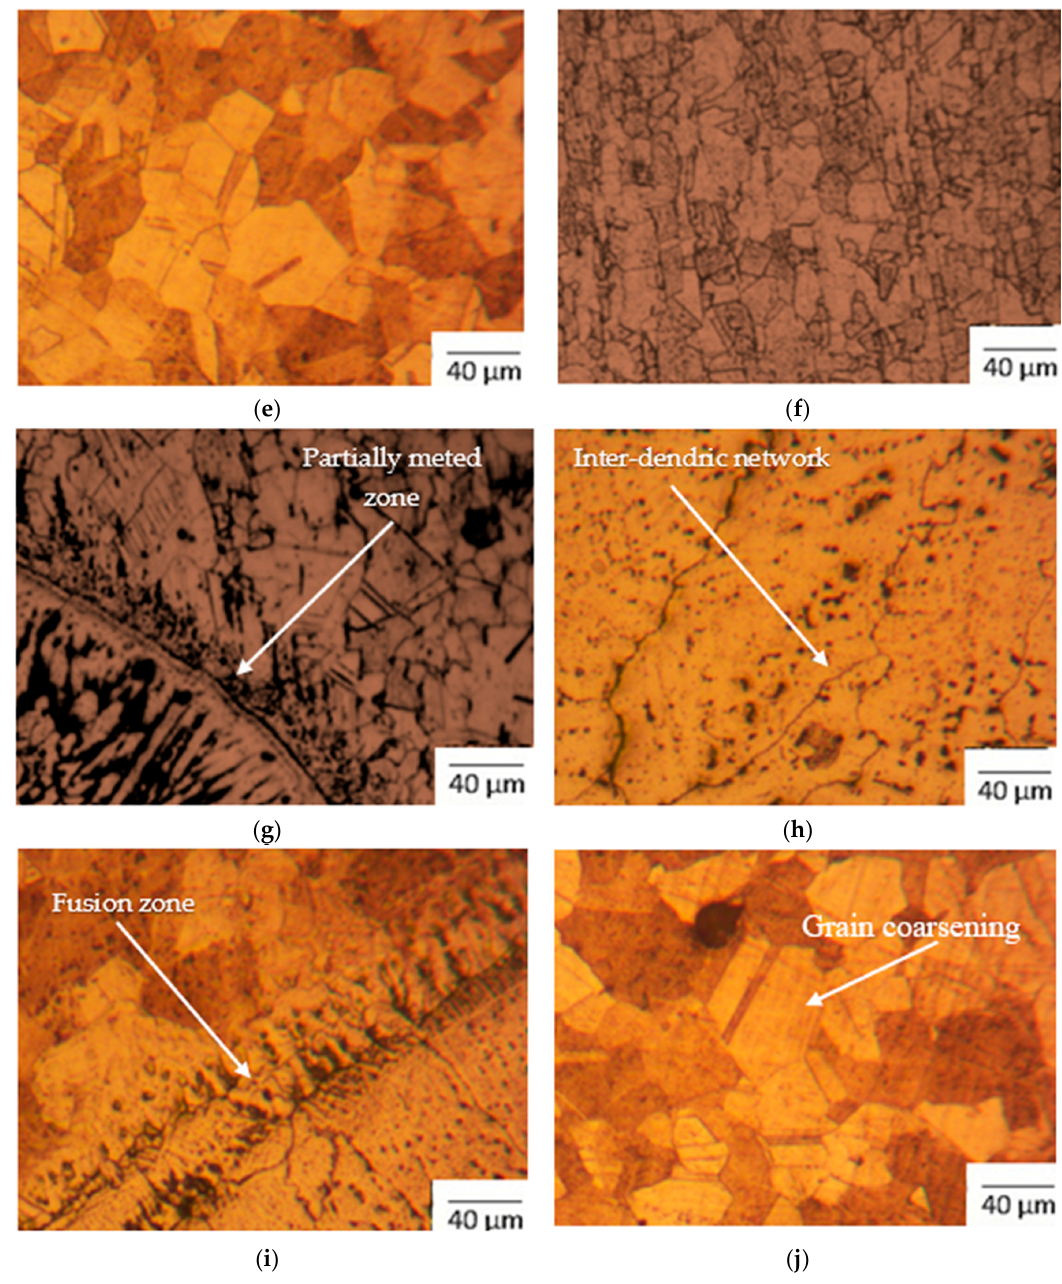
Figure 3. ( a ) Specimen cryo-treated (CT)-SS 316L HAZ; ( b ) specimen CT-SS 316L weld fusion; ( c